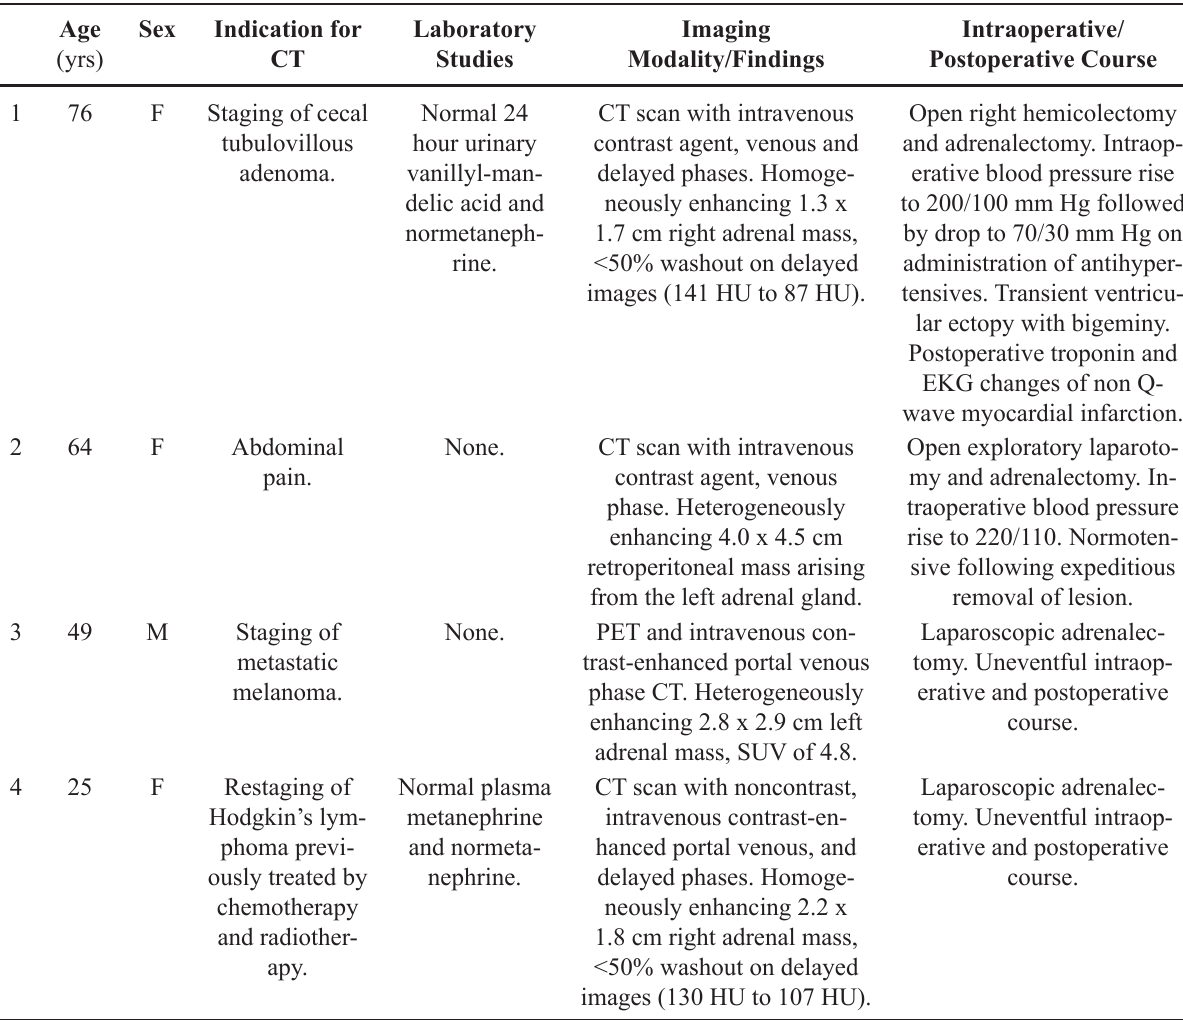
Table 1 – Clinical, imaging, and operative characteristics of four patients undergoing resection of an unsuspected pheo-